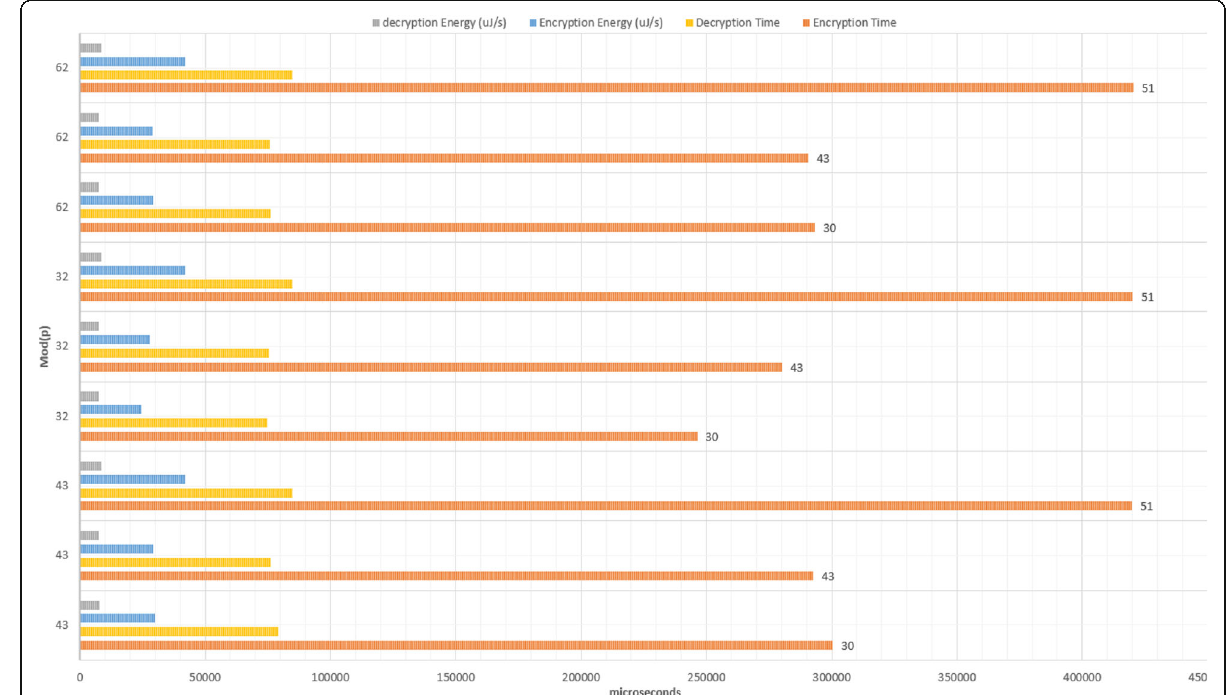
Fig. 2 Computation and memory performance of the proposed